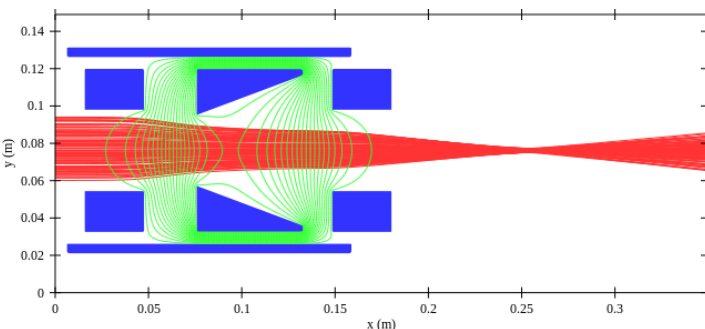
Figure 11. The asymmetrical einzel lens with a linearly tapered middle